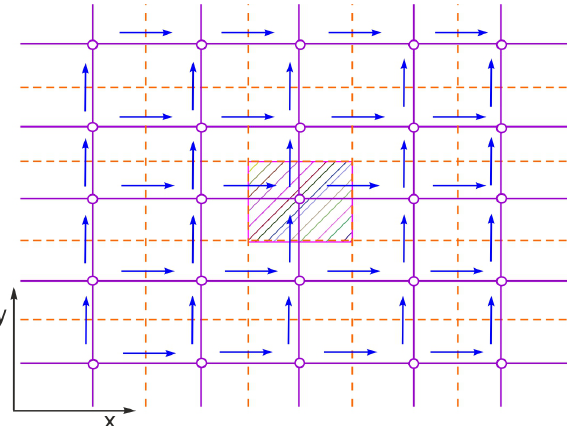
Figure 2: A chess grid and appropriate